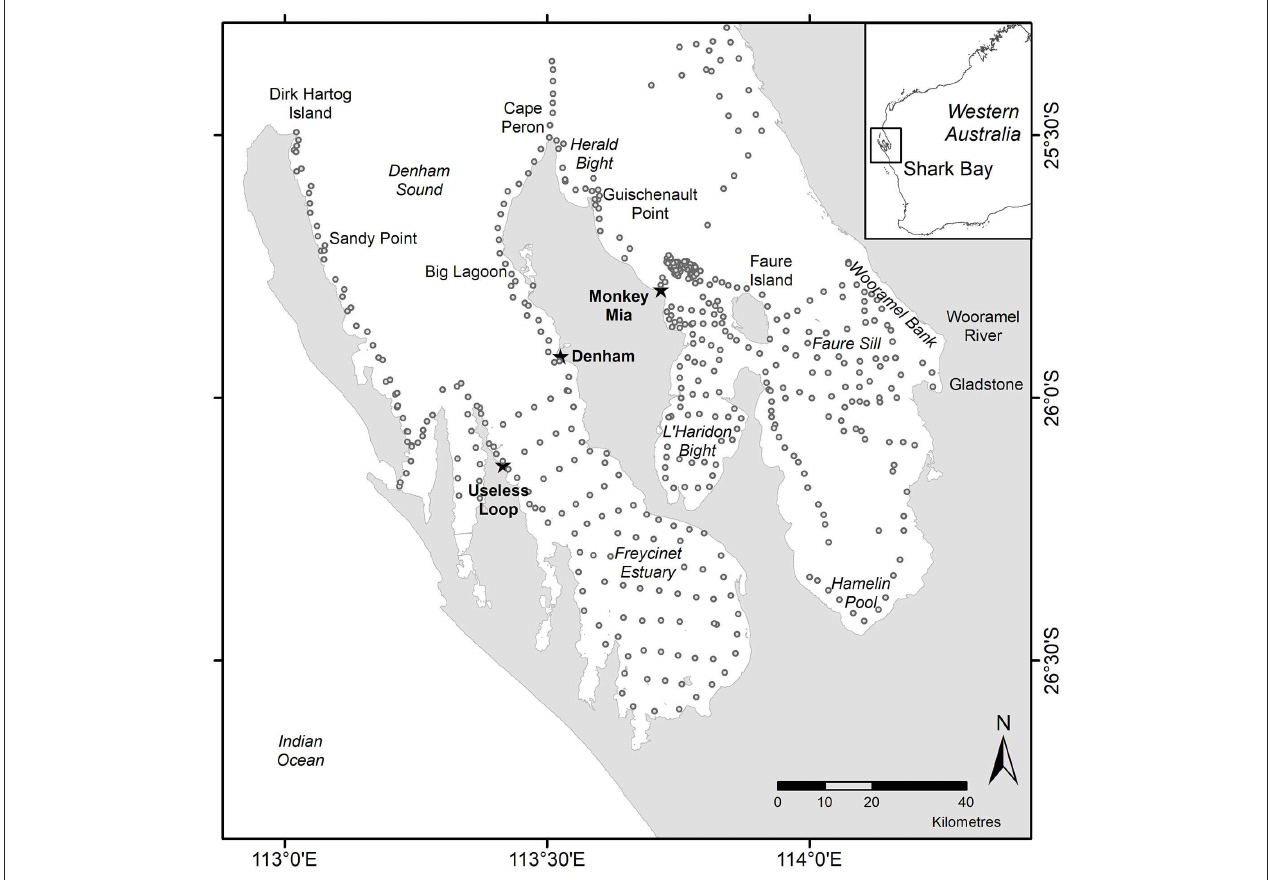
FIGURE 1 | Map of Shark Bay showing marine regions (italics), towns (bold and starred) and specific sampling locations (normal font) used in the text. Open circles show seagrass sampling locations